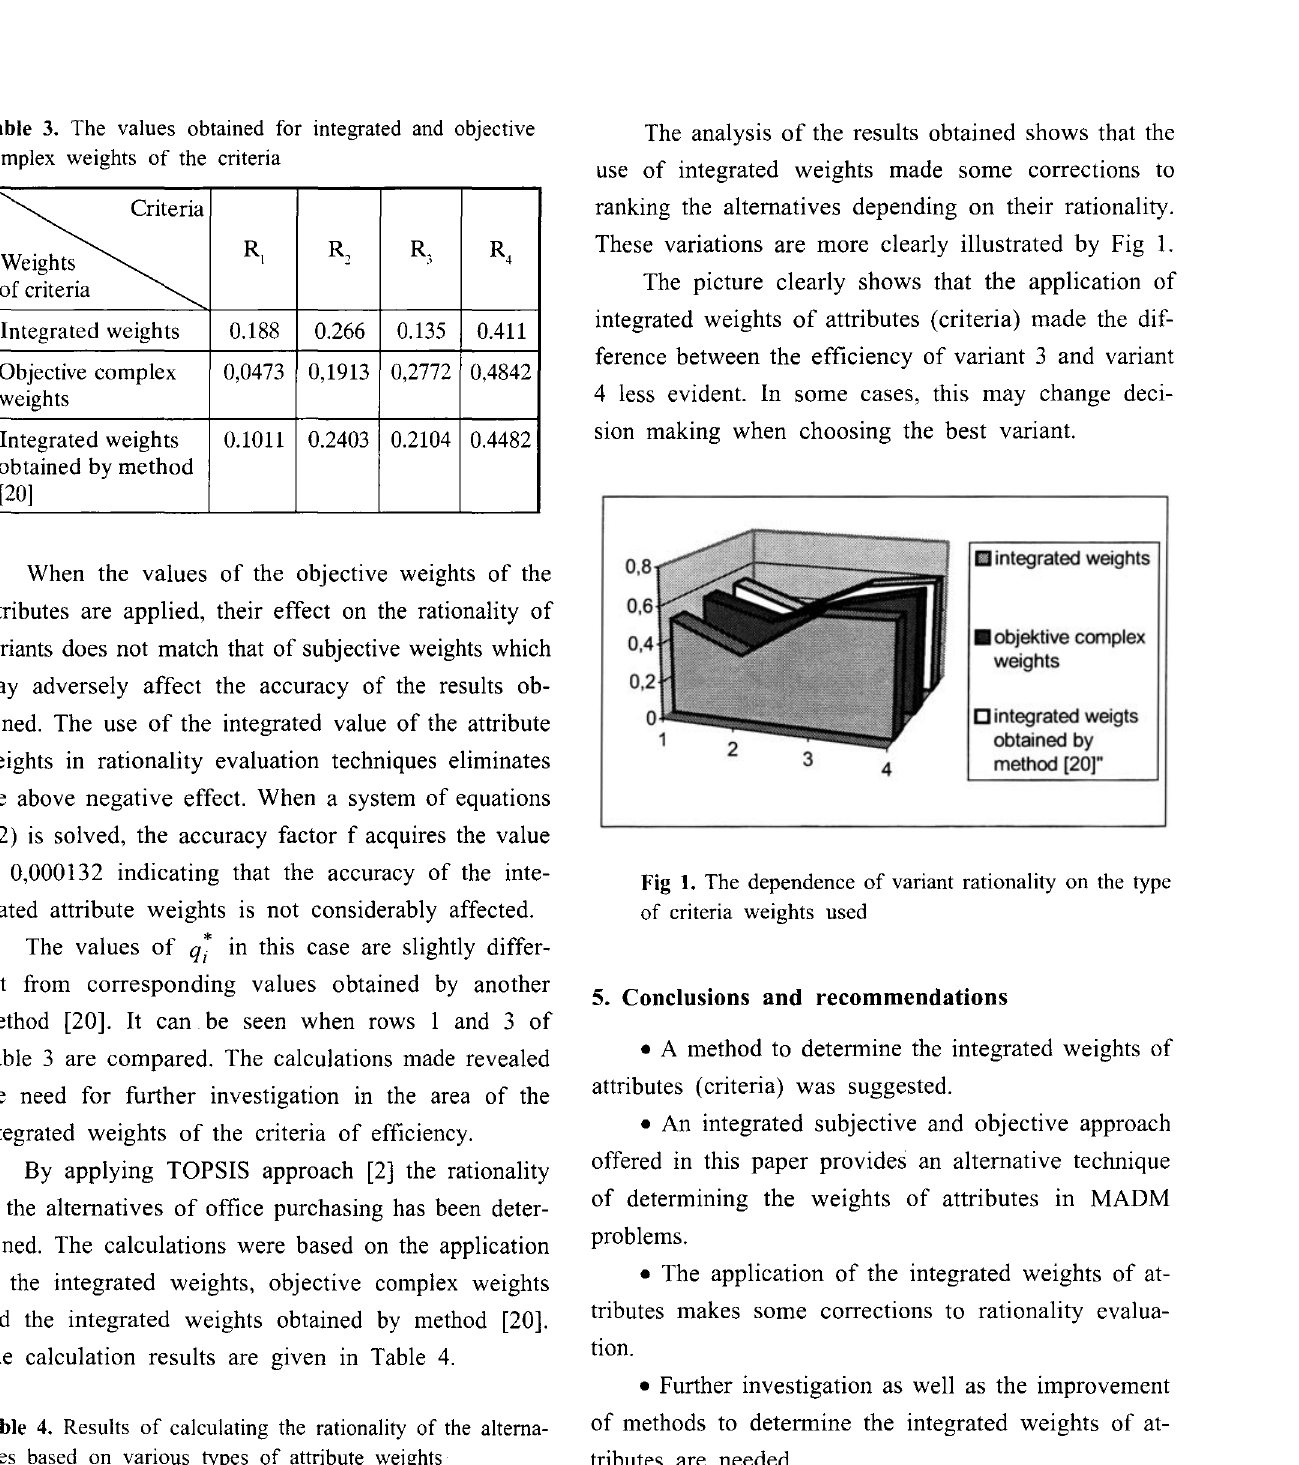
Table 4. Results of calculating the rationality of the altema tives based on various types of attribute weights